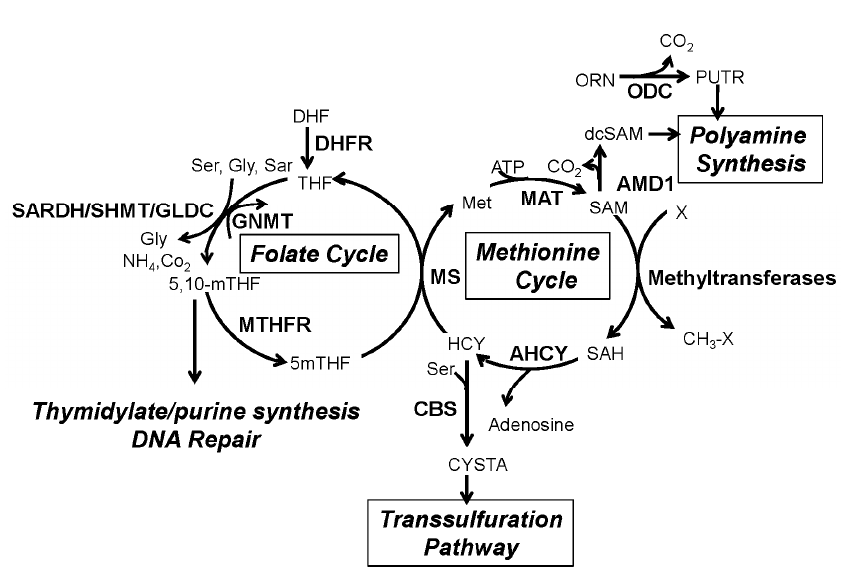
Figure 1. One-carbon metabolism and associated pathways. One-carbon metabolism involves the transfer of methyl groups to various substrates and cofactors within the folate and methionine cycles, and the polyamine biosynthetic and transsulfuration pathways. Methyl groups are utilized in the synthesis of nucleotides, and polyamines, as well as, DNA and protein methylation reactions. Enzymes are depicted in bold, while metabolites/substrates/cofactors are in regular font. Enzyme abbreviations are as follows: DHFR: Dihydrofolate reductase; SARDH: Sarcosine Dehydrogenase; SHMT: Serine